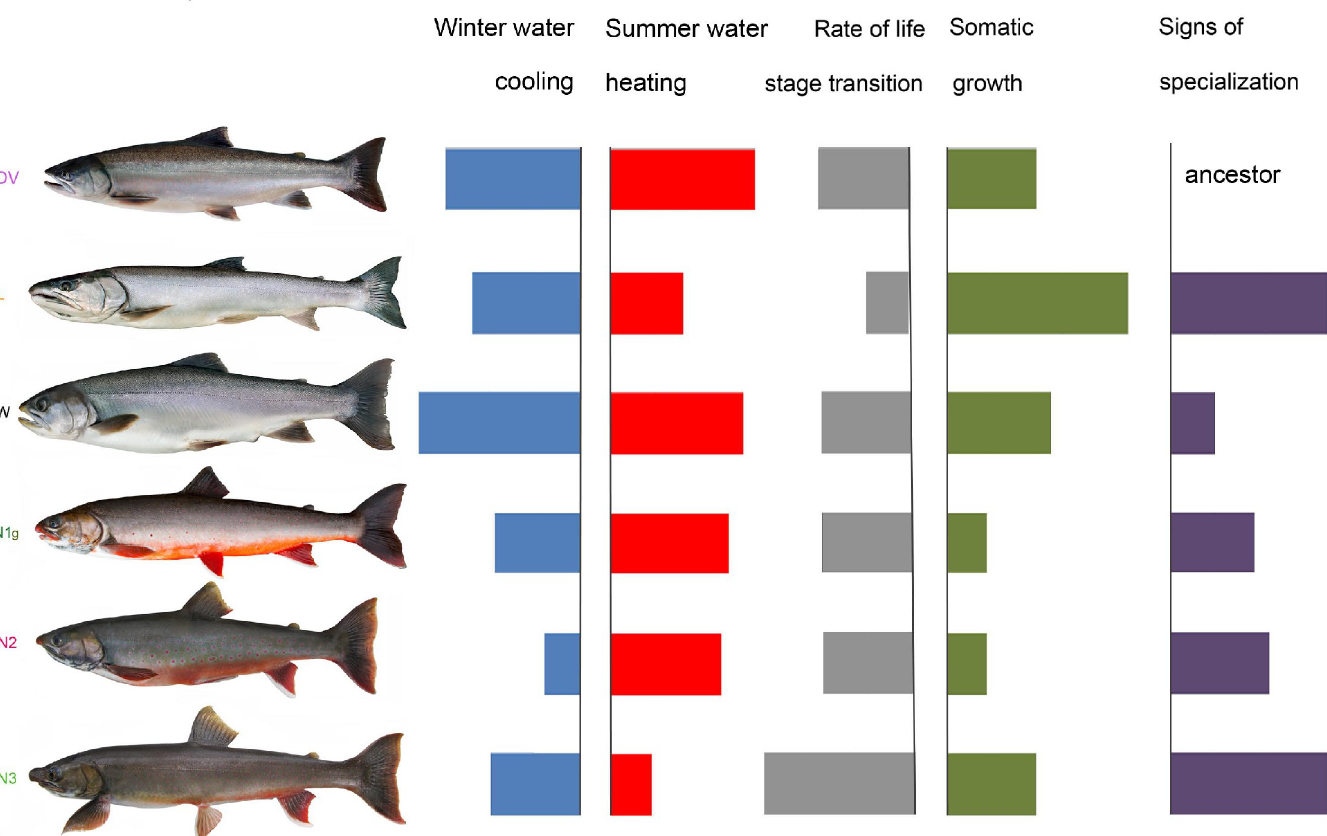
Fig 5. A brief comparison of the developmental temperatures, the rate of life stage transition and the early-life somatic growth among the Lake Kronotskoe charr morphs and the anadromous Dolly Varden. Sector length indicates the trait intensity, as well as overall specialization.